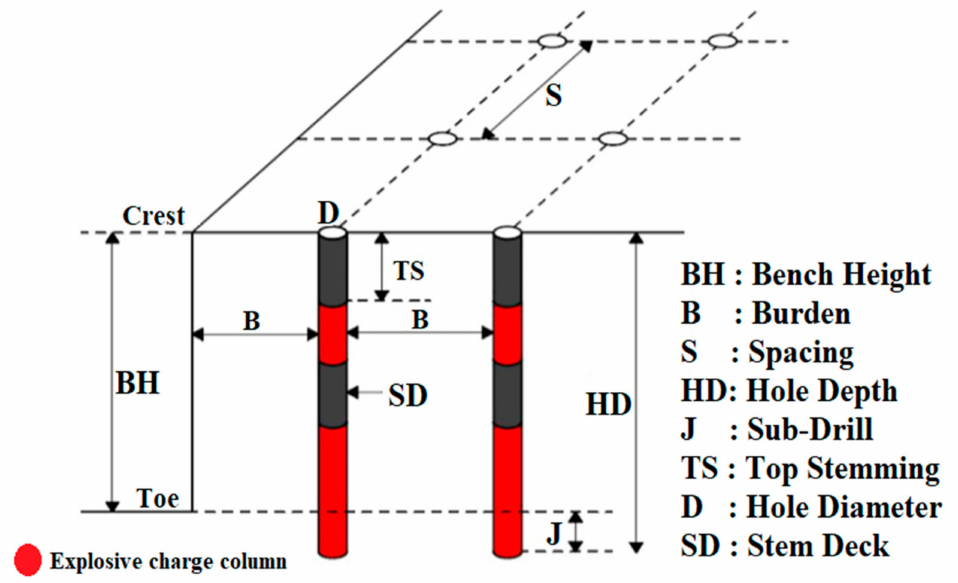
Figure 2. Geometrical input parameters used for rock fragmentation prediction with the bench edges (Crest and Toe)